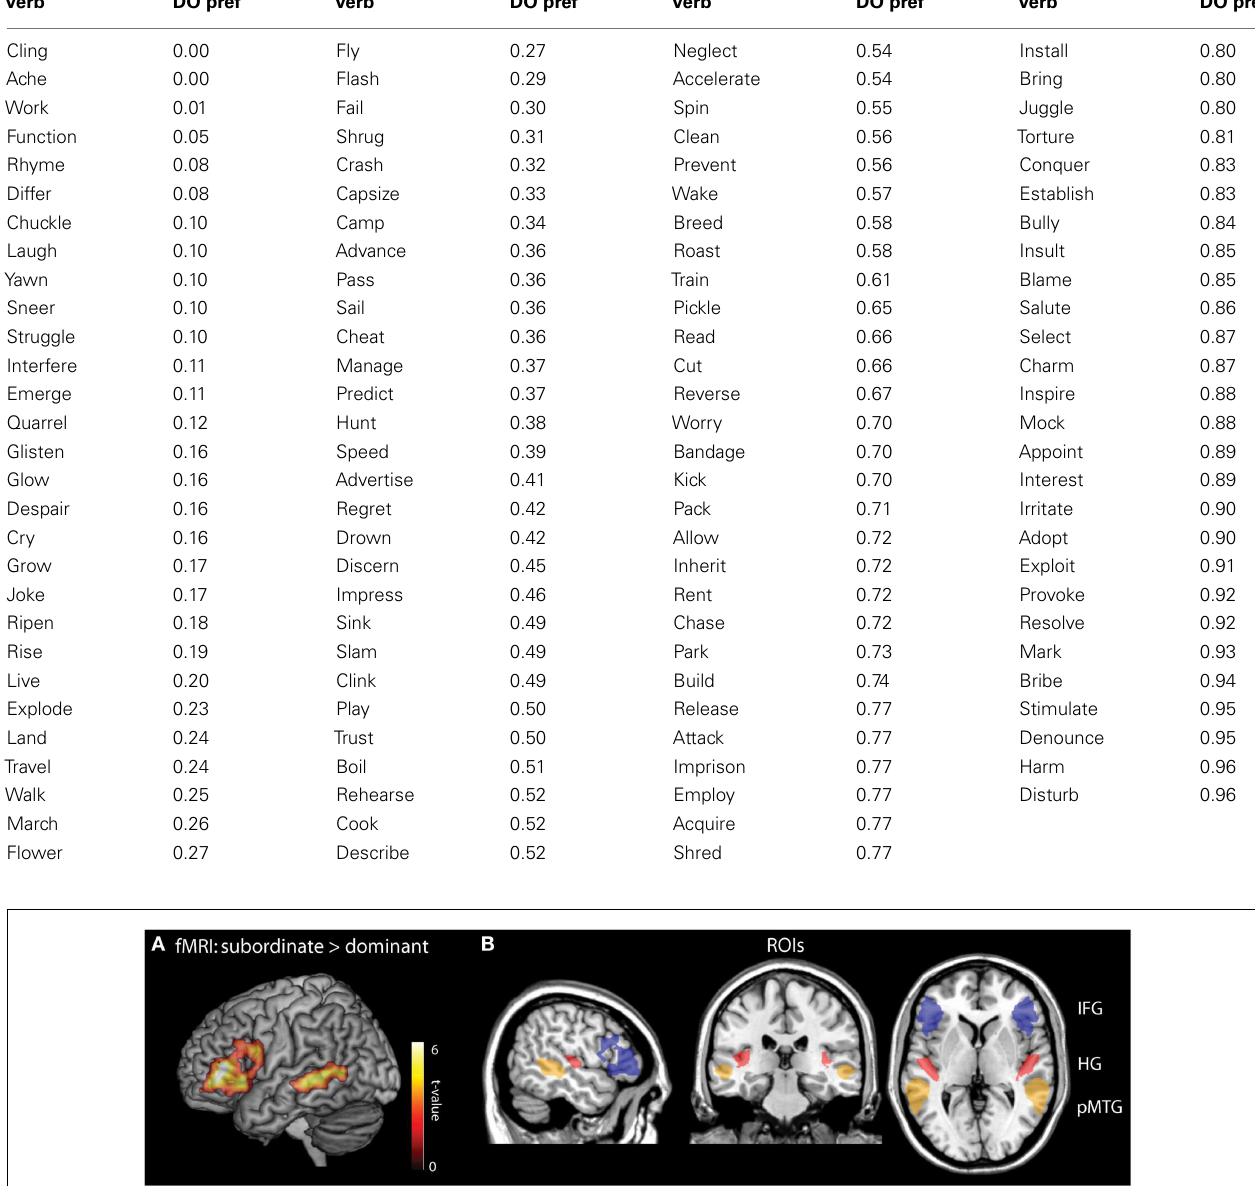
FIGURE 5 | Regions of interest (ROIs) used in the MEG RSA analysis . (A) Functional ROIs were obtained from an fMRI contrast of subordinate > dominant sentences. (B) The entire complement of ROIs used